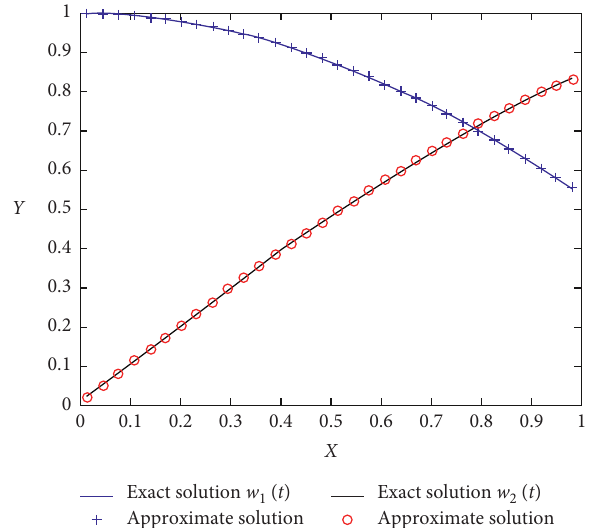
Figure 3: Comparison of exact and approximate solution for N � 32 for Problem 3.